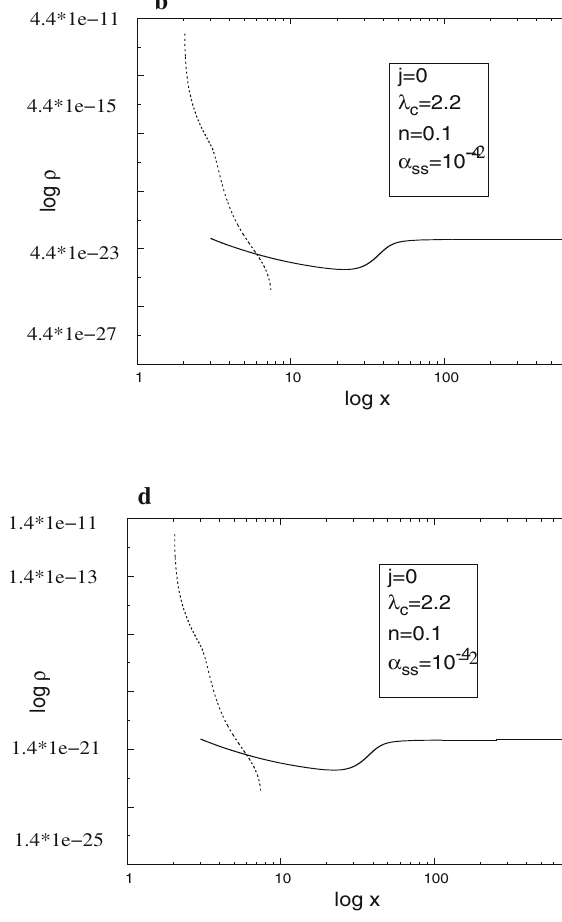
tion disc flow with viscosity α ss = 10 − 2 , around a non-rotating BH for MCG using NFW and Einasto profile respectively. Accretion and wind curves are depicted by solid and dotted lines